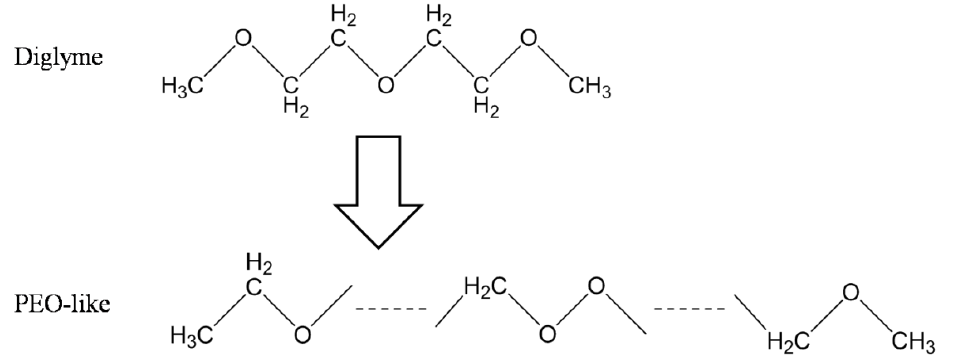
Figure 1. The chemical reaction of the plasma polymerization of polyethylene oxide (PEO)-like